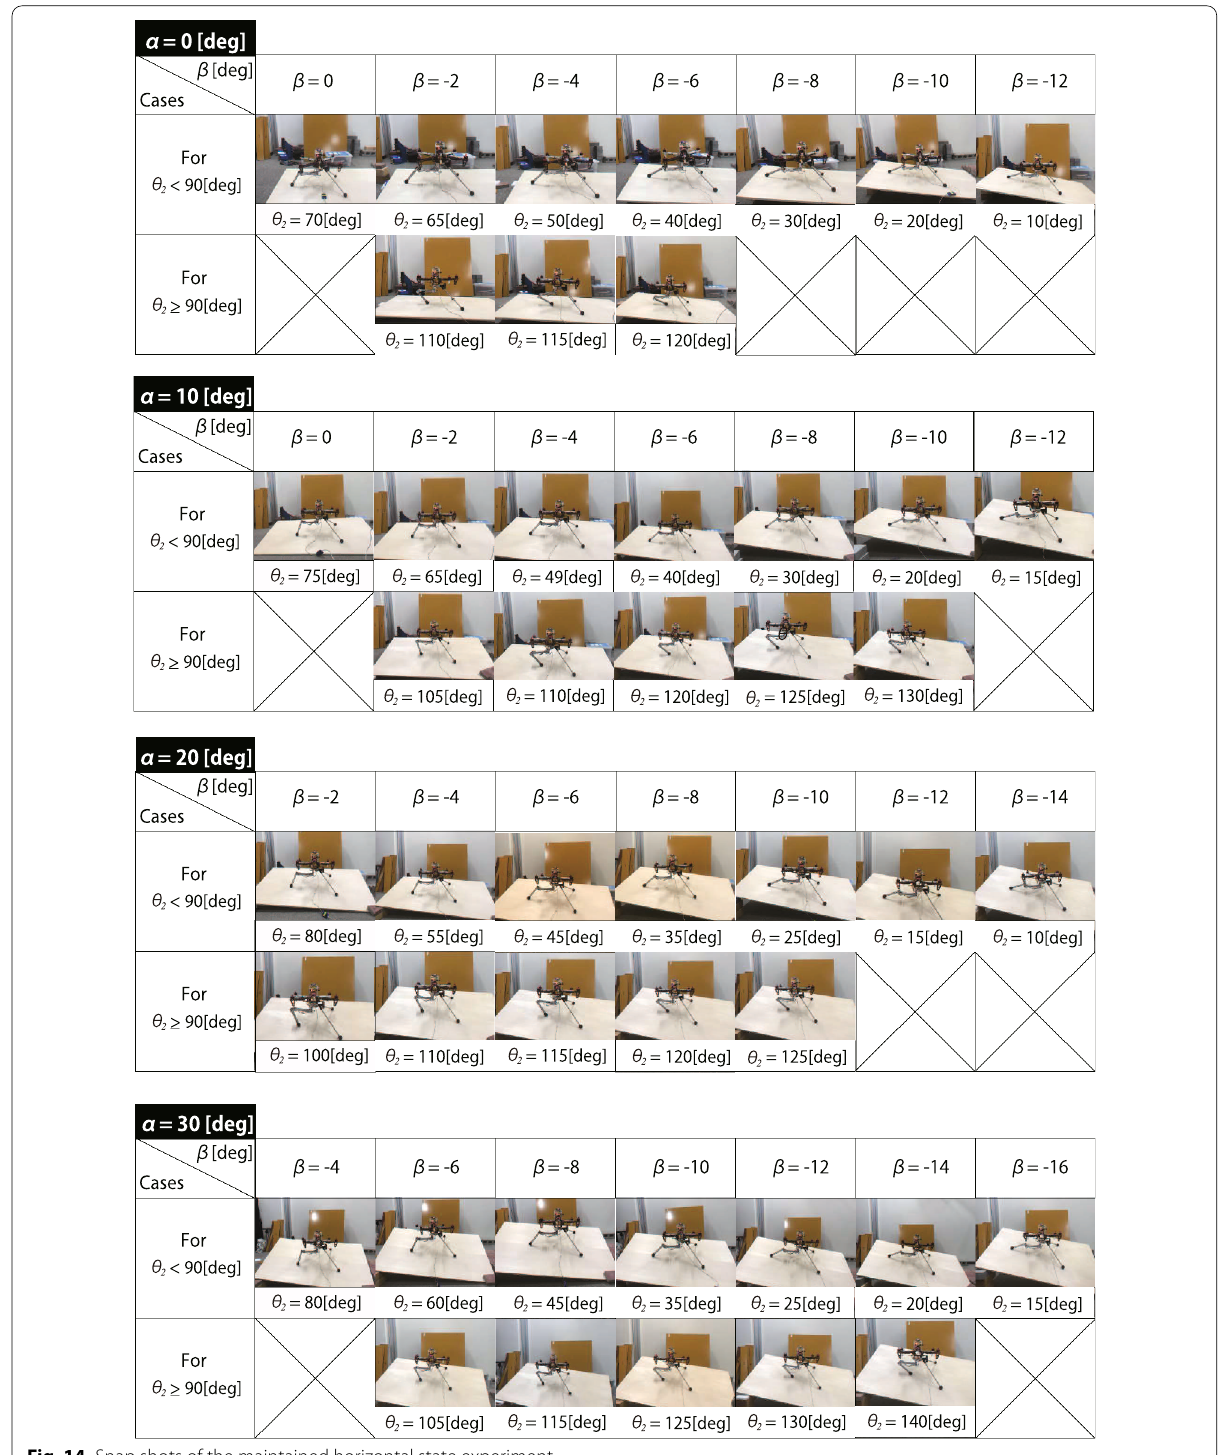
Fig. 14 Snap shots of the maintained horizontal state